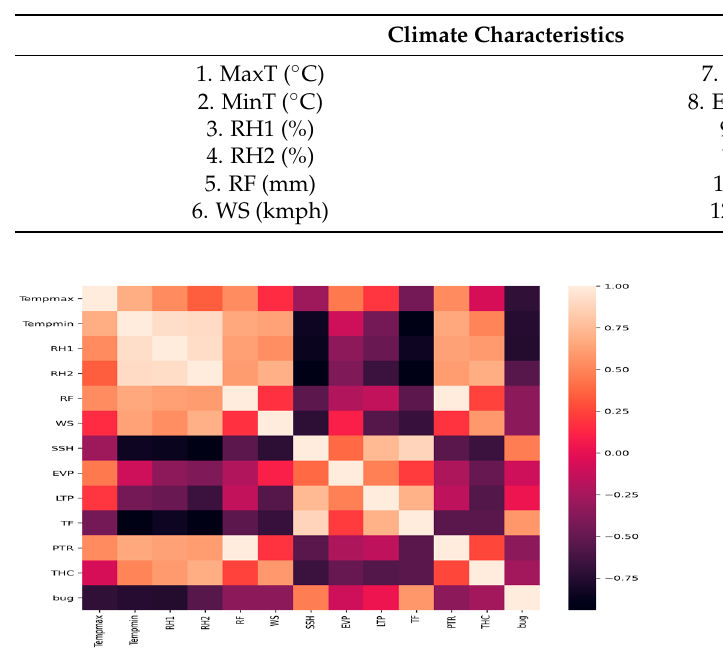
Figure 12. Heat map of the correlation coefficients in Experiment 3.